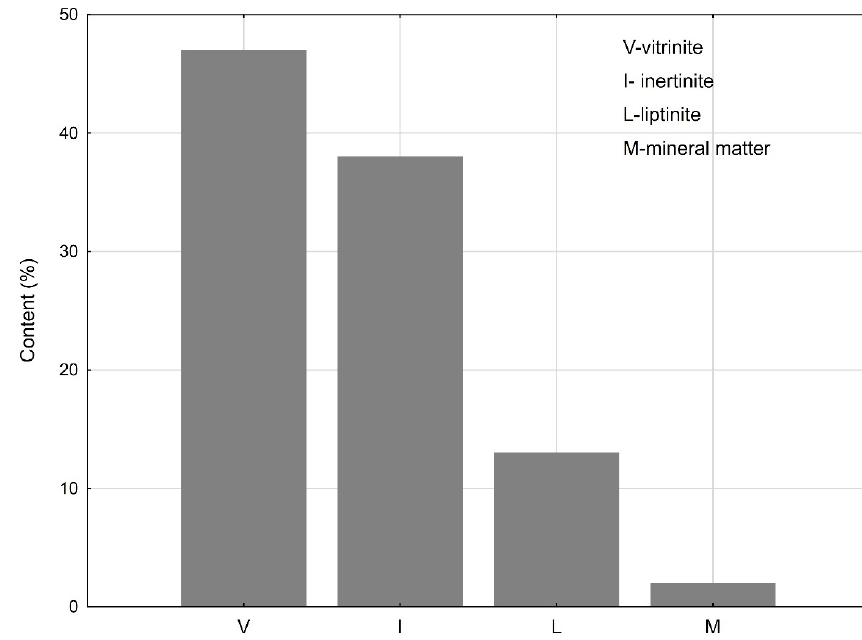
Figure 3. Petrographic composition of the raw sample.